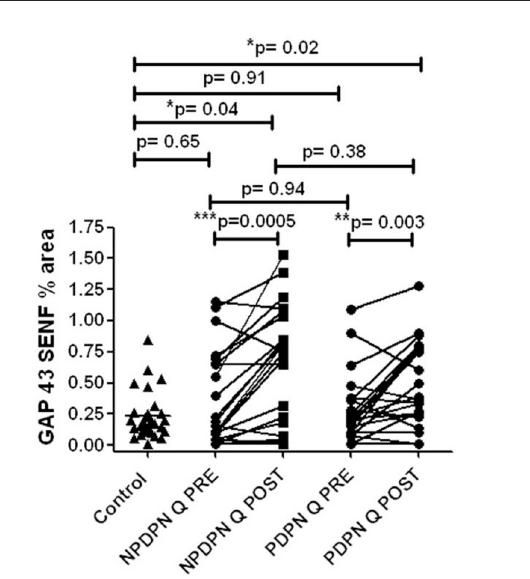
FIGURE8 GAP 43 immunohistochemistry from skin biopsies in non–painful (NPDPN Q + SOC) and painful (PDPN Q + SOC) Diabetic Peripheral Neuropathy following Capsaicin 8% patch Qutenza (Q) treatment. Sub–epidermal fiber density (SENF, % area) in 30 µ m sections in NPDPN Q + SOC and PDPN Q + SOC at baseline (Q PRE) and statistically no significant difference in NPDPN and PDPN before (Q PRE, p = 0. 94;